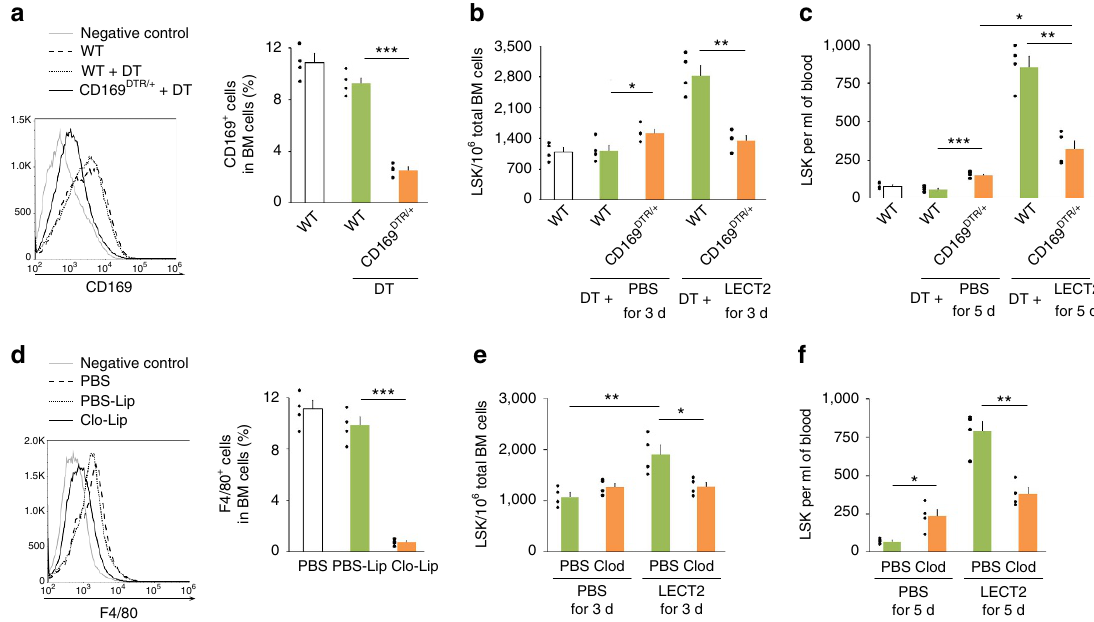
Figure 4 | Macrophages mediate the effect of LECT2 on HSC expansion and mobilization. ( a ) The number of CD169 þ cells in WT mice and WT or CD169 DTR/ þ mice injected with DT. ( b ) The number of LSK cells in the BM of WTor CD169 DTR/ þ mice after PBS or LECT2 treatment. ( c ) The number of LSK cells in the blood of WTor CD169 DTR/ þ mice after PBS or LECT2 treatment. ( d ) Effect of PBS liposomes (PBS-Lip) and clodronate liposomes (Clo-Lip) on macrophage number. ( e ) Effect of LECT2 on the number of BM LSK cells after macrophage depletion. ( f ) Effect of LECT2 on the number of blood LSK cells after macrophage depletion; n ¼ 4. The small black dots in histograms are data points. The data represent means ± s.e.m. The data are representative of two independent experiments. * P o 0.05, ** P o 0.01, *** P o 0.001 using one-way